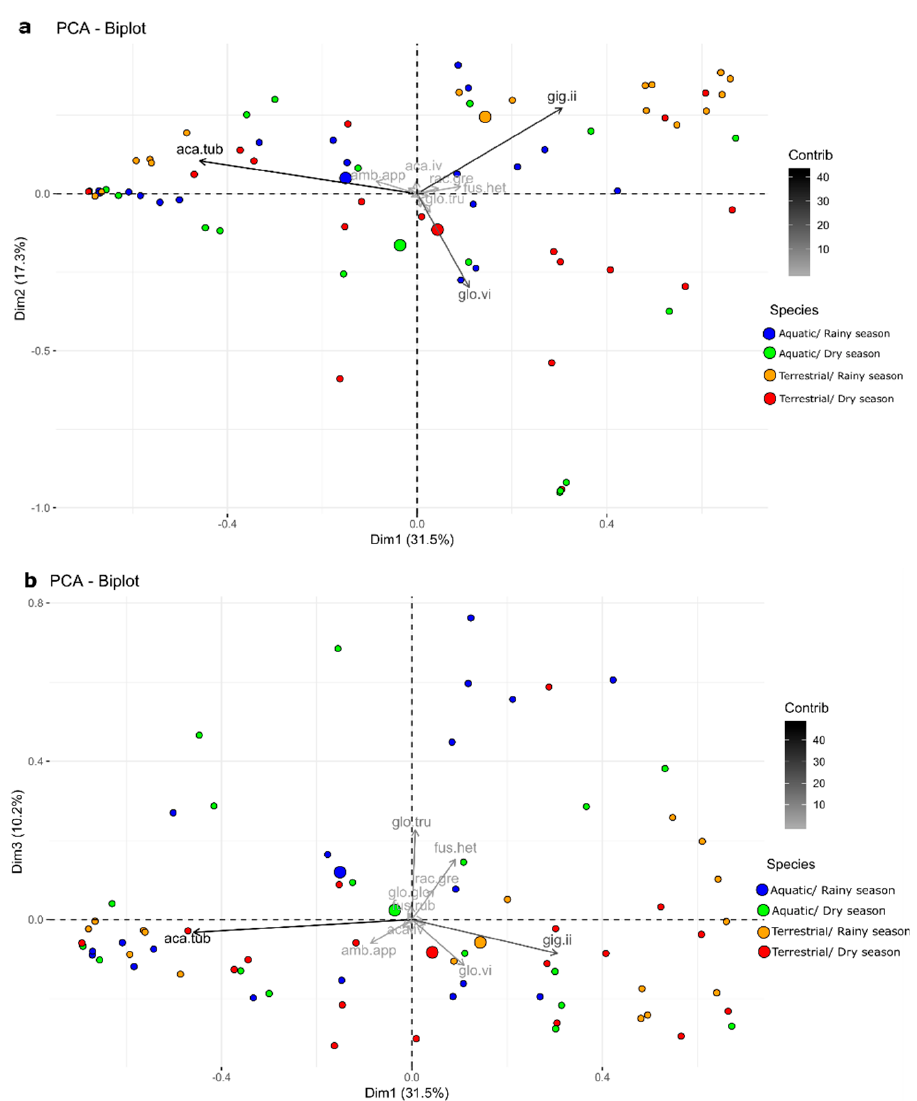
Figure 2. Principal Component Analysis of AMF species related to aquatic/terrestrial conditions and rainy/dry periods. Species—aca.tub: Acaulospora tuberculata , amb.app: Ambispora appendicula , fus.het: Fuscutata heterogama , gig.ii: Gigaspora sp., glo.tru: Glomus trufemii , glo.glo: Glomus glomerulatum , fus.rub: Fuscutata rubra , rac.gre: Racocetra gregaria , glo.vi: Glomus cf. trufemii 2, aca.iv: Acaulospora cf. morrowiae . In ( a ) we have PC1 with PC2 and ( b ) PC1 with PC3. In both PCA graphics, the larger dots indicate the centroids of conditions and periods.